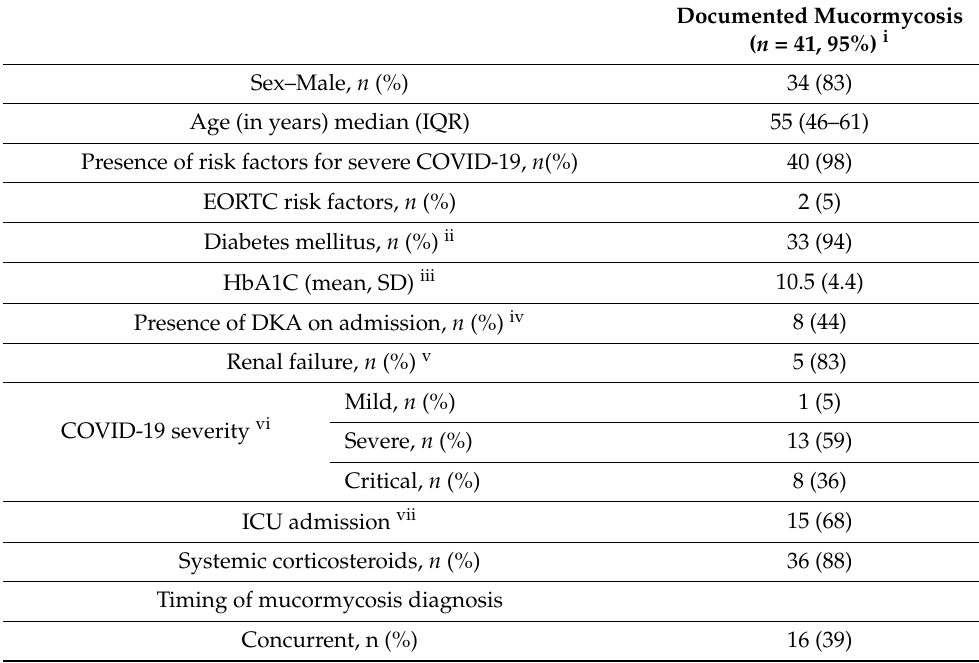
Table 1. Characteristics of the 41 patients with COVID-19 associated mucormycosis